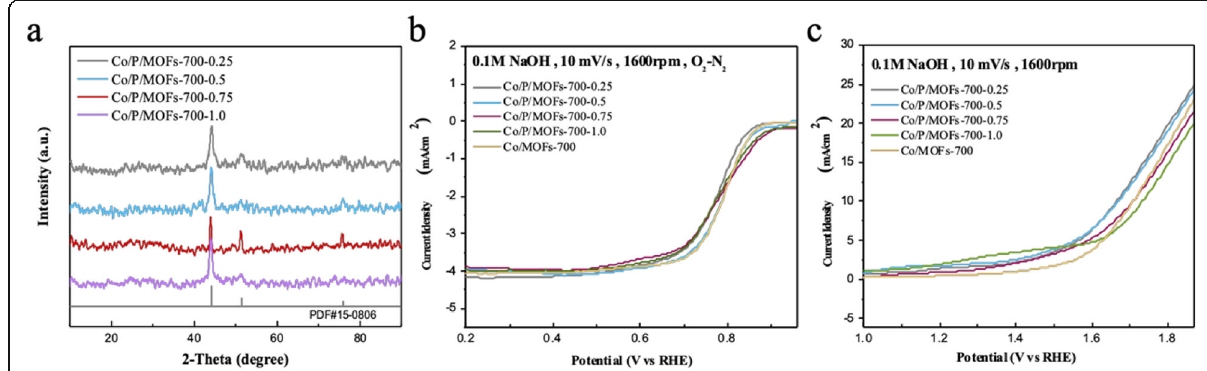
Fig. 4 a XRD patterns of doping different contents of phosphorus source into Co-MOFs. b , c ORR and OER polarization curves of Co/MOFs-700, Co/P/MOFs-700-0.25, Co/P/MOFs-700-0.5, Co/P/MOFs-700-0.75, and Co/P/MOFs-700-1.0, respectively